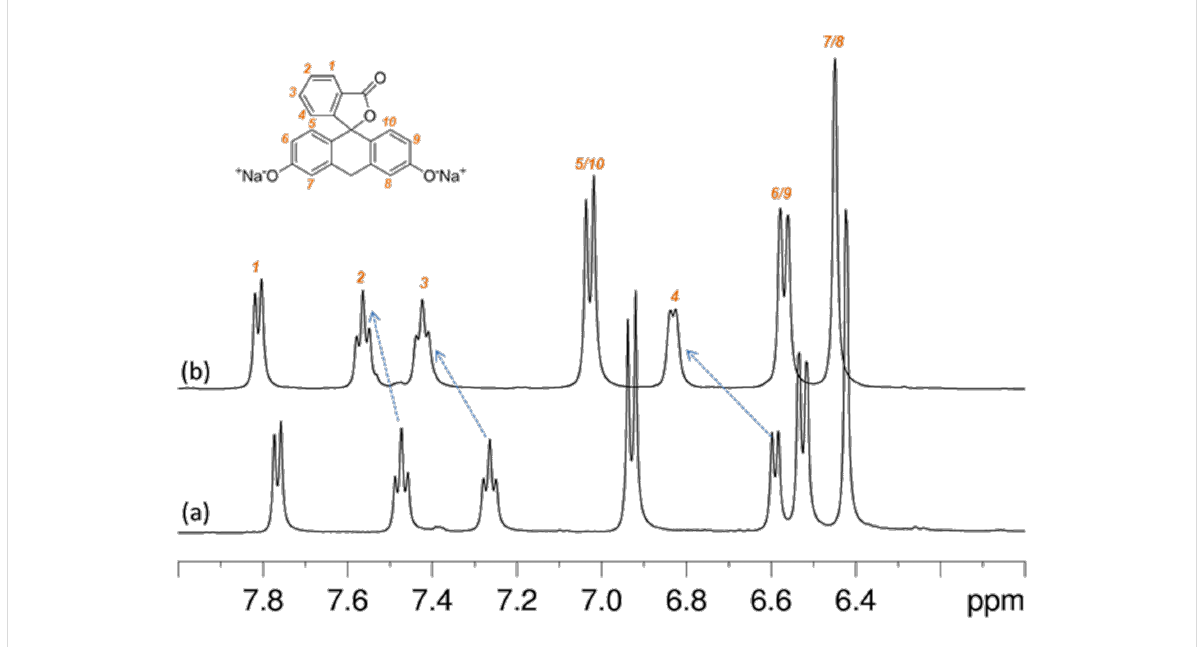
Figure 6: NMR spectra of fluorescein in D 2 O solution (a) and in the presence of the hyper-branched β -CD polymer (b). pH range: 8.25–7.50.